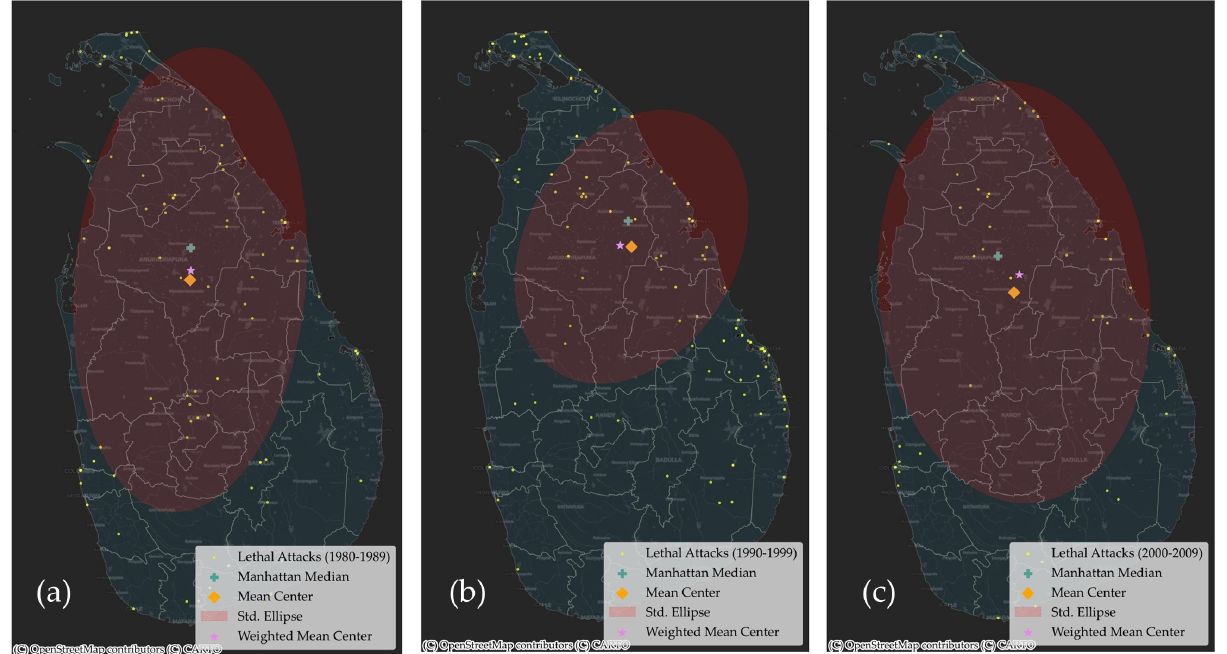
Figure 20. Spatiotemporal evolution of lethal attacks in Sri Lanka. ( a ) Lethal attacks in the decade